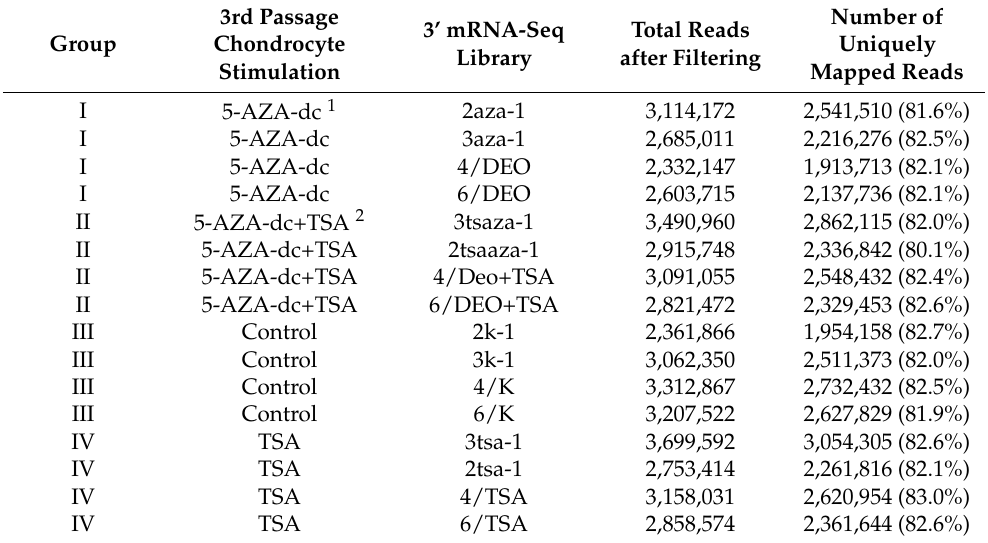
Table 1. Results of the alignment of 3’ mRNA-seq reads against the EquCab 3.0 reference sequence of the horse